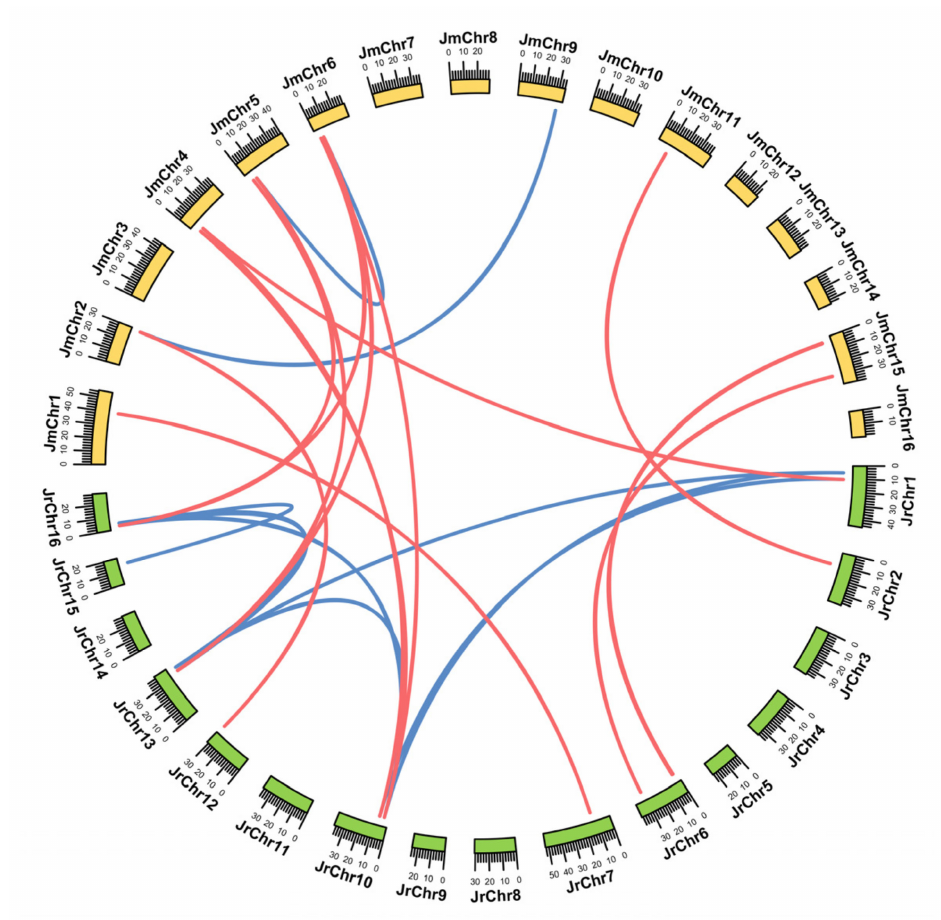
Figure 4. Genome-wide synteny analysis for WAK/WAKL genes among J. regia and J. mandshurica . The orthologous and paralogous WAK/WAKL genes were mapped onto the chromosomes and linked by each other. Red lines indicate orthologous gene pairs, blue lines indicate paralogous gene